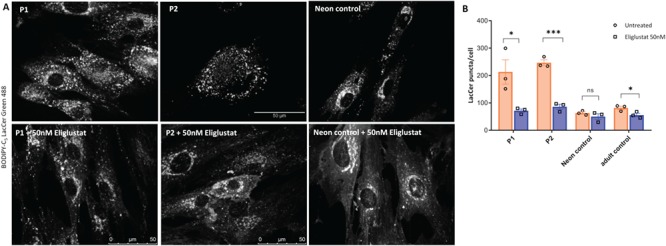
Treatment with eliglustat tartrate, an inhibitor of glucosylceramide synthase, improved Lactosylceramide trafficking in patient-derived fibroblasts. Patient-derived (P1, P2) and control fibroblasts were incubated with 50 nM eliglustat tartrate for 24 h. (A) Representative confocal images of patients and control fibroblasts labelled with BODIPY-LacCer as described in the methods. (B) Quantification of BODIPY-LacCer puncta in patients and control fibroblasts (n ≥ 10 cells per each cell line). Each open circle and square represent mean BODIPY-LacCer labelled puncta in untreated and eliglustat treated cells per experiment. The orange and blue bars indicate mean ± SEM of untreated and eliglustat treated cells from three independent experiments. Scale bars, 75 μm. *, P < 0.05; ***, P < 0.0005; ns, not significant in two-tailed unpaired Student’s t-test.